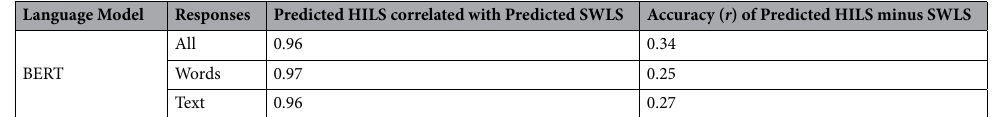
Table 4. The Discriminant Validity of Language Models: Significantly Predicting the Harmony in life scale Minus the Satisfaction with life scale. N = 608. All correlations (Pearson r) were significant at p < .001. Accuracy (r) of Predicted HILS minus SWLS = predicting the difference score of the normalized HILS minus the normalized SWLS, where normalization was achieved by respectively subtracting the column mean from each score.